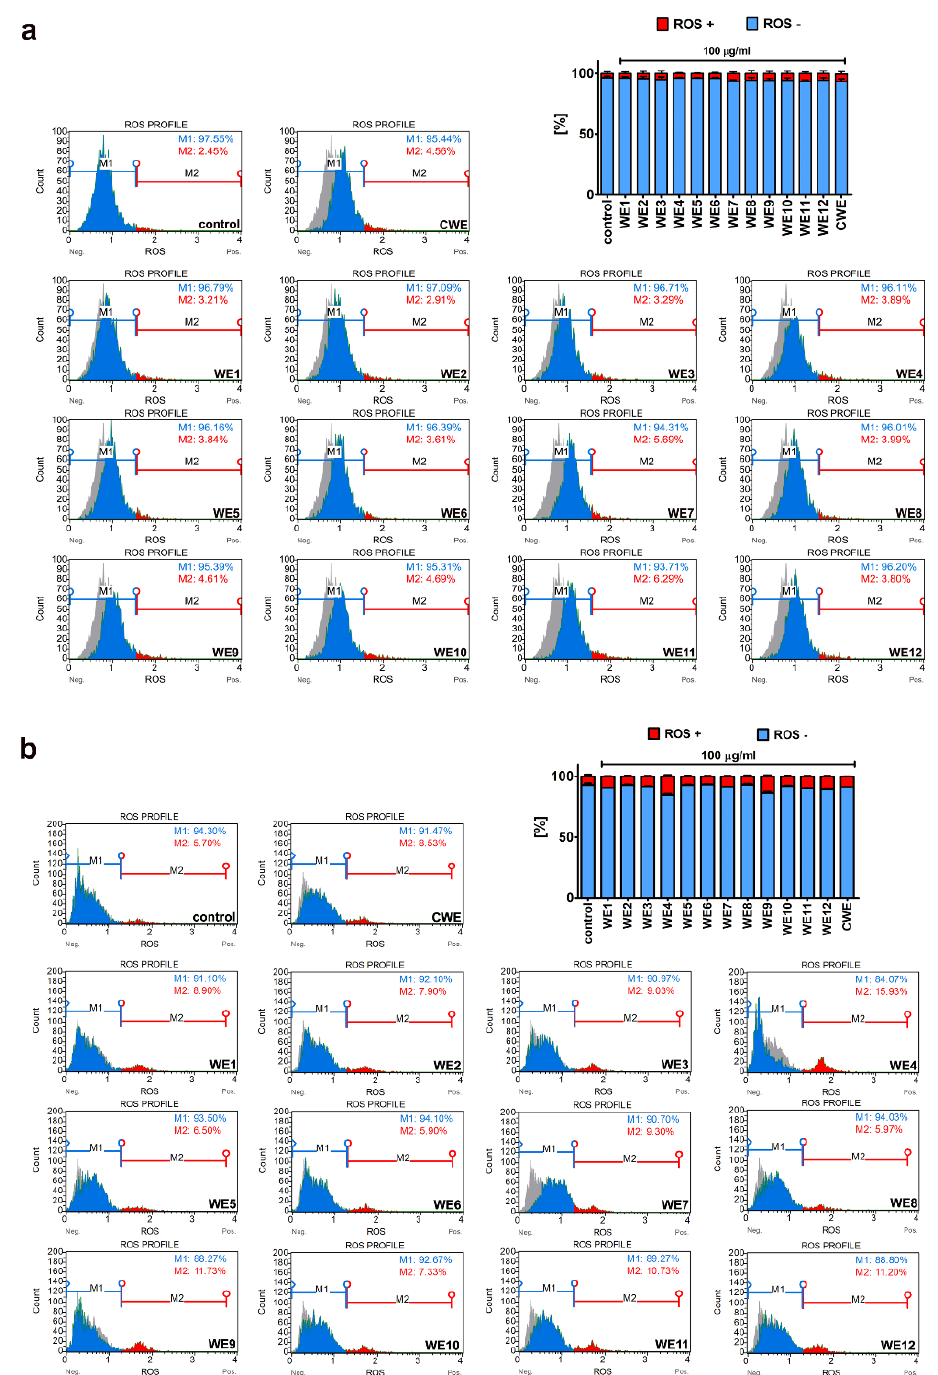
Figure 7. Extract-mediated changes in the levels of superoxide in BJ cells (( a ) 100 µ g / mL water extracts) and HEK cells (( b ) 100 µ g / mL water extracts). ( a , b ) The e ff ects of water extracts (WE, twelve modified clones from WE1 to WE12) are shown. Control clone water extract is denoted as CWE. Superoxide levels were measured using a Muse ® Cell Analyzer and a Muse ® Oxidative Stress Kit. Representative histograms are presented. The control sample is denoted as a grey histogram in each sample analyzed. Bars indicate SD, n = 3.